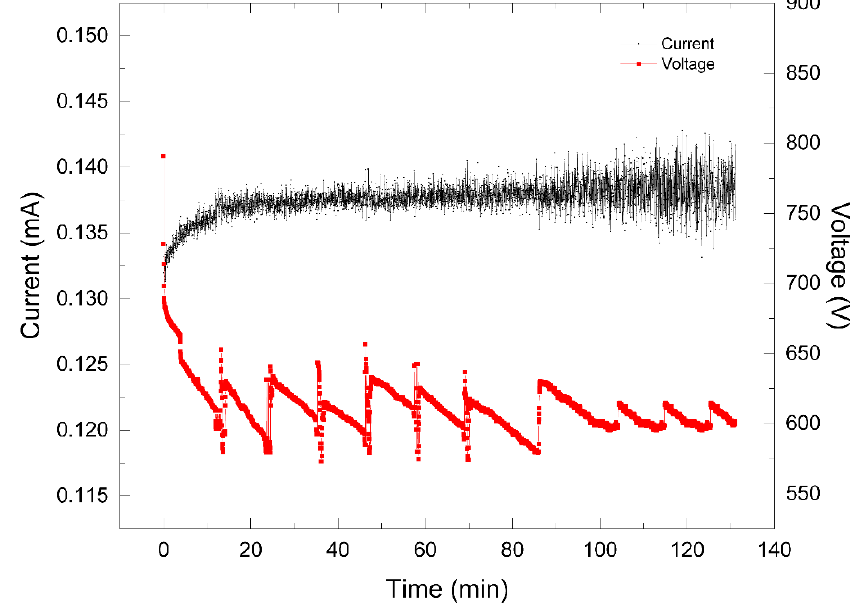
Figure 5. Graphic behavior of voltage and current during plasma at atmospheric pressure (PAP) treatment for azo dye Carmoisine (5 ppm) as a function of electrical measurement. The pH of the sample was adjusted to 5.2. The treated volume was 1.0 L. The current is black line, and the voltage is the red line.